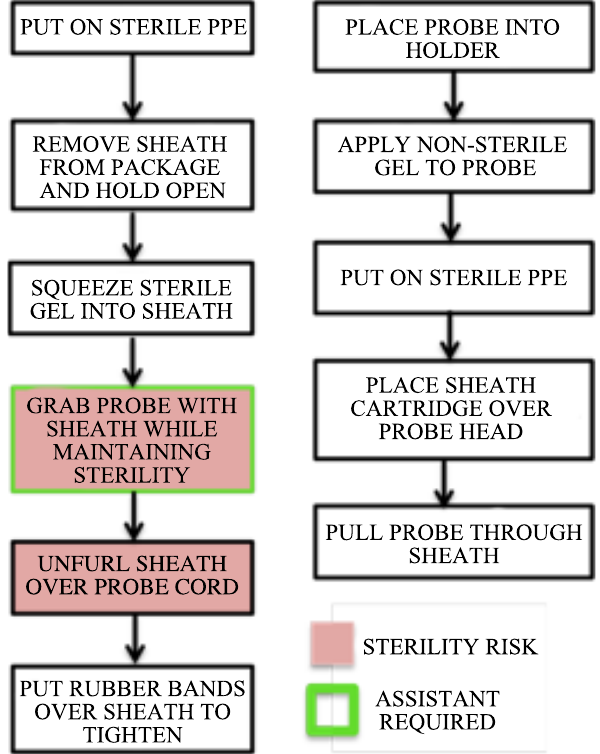
Figure 3. Process flow diagram comparing the current (left) proce- dure to that using the new device